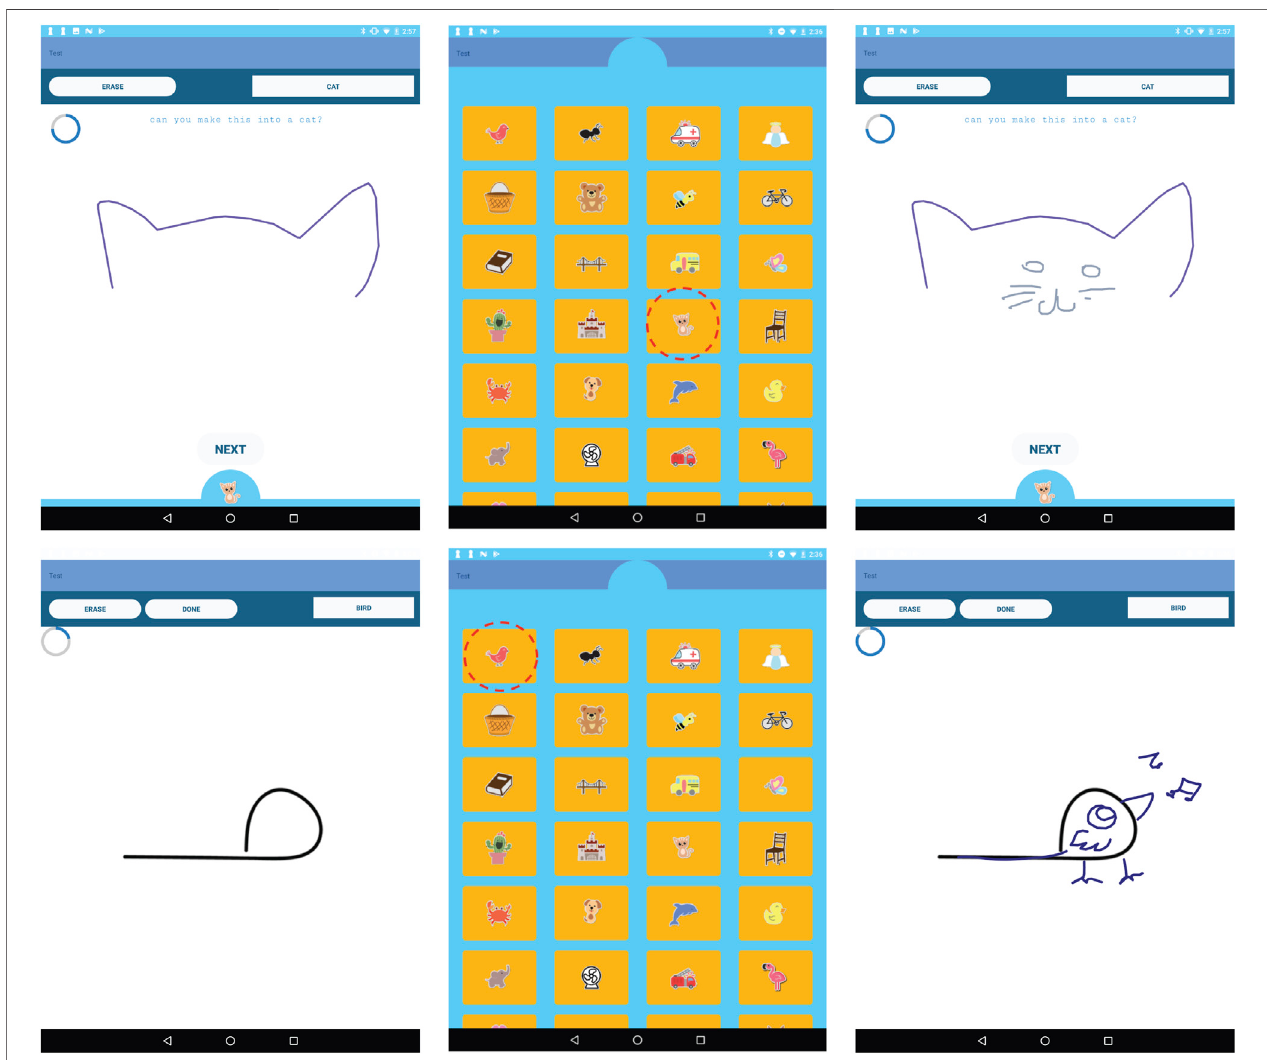
FIGURE 2 | Interface screenshots of the Magic Draw game explaining the child-robot gameplay. (A) The child draws a starting prompt (cat ears). (B) The child selectsatargetcategory(cat). (C) Therobottriestoconvertthestartingprompt(circle)intothetargetcategory(cat). (D) Playersswitchturnsandtherobotgivesthechild a starting prompt. (E) The robot selects the category (bird). (F) The child converts the starting prompt to a bird. (order: left to right starting top-left).